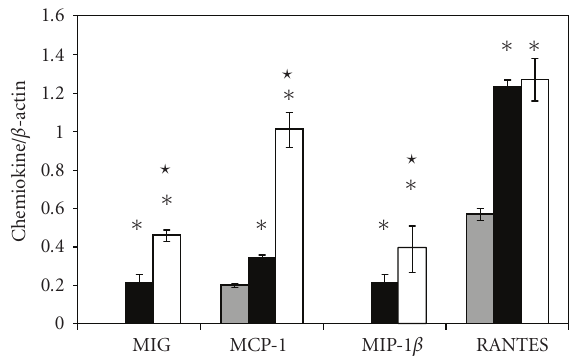
Figure 6: mRNA expression of MIG (CXCL9), MCP-1 (CCL2), MIP-1 β (CCL4), and Rantes (CCL5) in cardiac tissue of Balb/c mice infected with 1 × 10 5 BT of T. cruzi. Total RNA was obtained at day 21 post infection and chemokines expression was determined by RT-PCR as described in material and methods. PCR products were analyzed in 2% agarose gels stained with ethidium bromide. Semicuantitative analysis was done. Values are average of 4 mice from 3 independent assays. Grey bar control, black bar Ninoa strain and White bar Qro strain. In the case of MIG and MIP-1 β no detectable levels of chemokines were found in the control tissues. Significant di ff erences ( ∗ P < . 05) in chemokine expression were found in cardiac tissue of control versus infected mice. Di ff erences between T. cruzi strains were also founded ( (cid:2) P < .